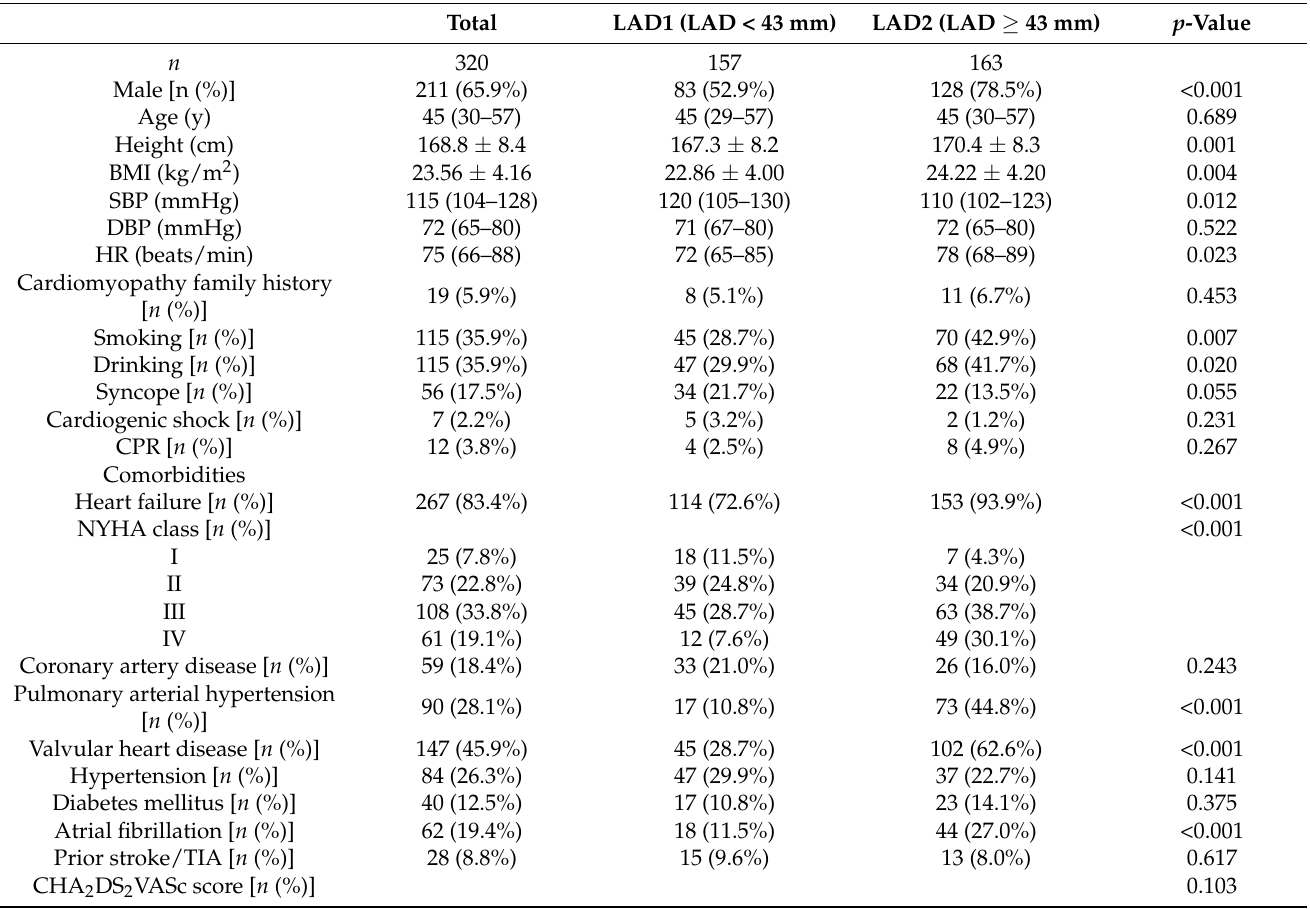
Figure 2. Distributions of left atrial diameter. LAD, left atrial diameter. Table 1. Baseline characteristics of patients with left ventricular